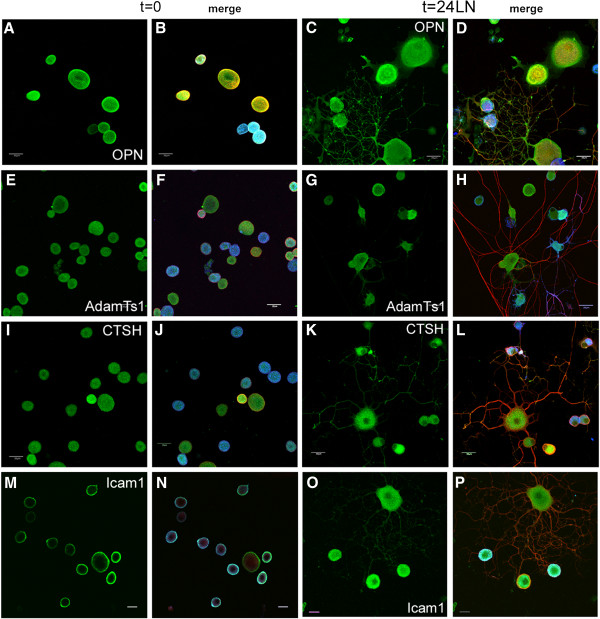
Expression of OPN, CTSH, AdamTs1 and Icam. ICC was used to detect the expression of osteopontin (A, C, green), AdamTs1 (E, G, green), CTSH (I, L, green), Icam (M, O, green); merged images show βIII tubulin (red, B, D, F, H, J, L, N, P) and IB4 binding neurons (blue) at t=0 and t=24LN. Densitometric analyses are presented in Supp Fig 2. Scale bar-A-L, 30 μm; M-P, 20 μm.